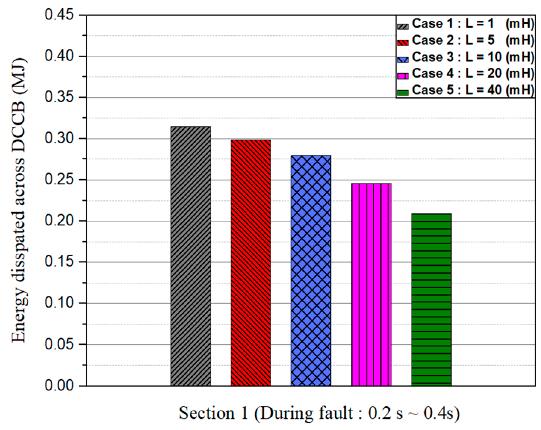
Figure 12. The comparison of energy dissipation across DCCB during fault period.